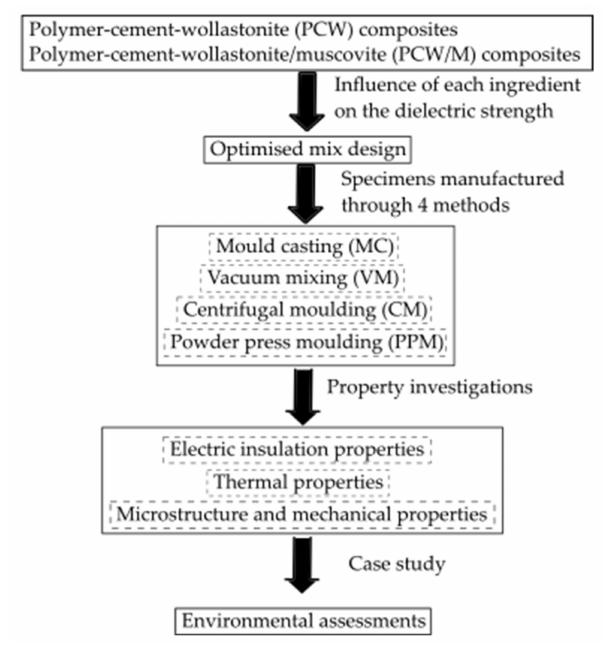
Figure 1. Flow chart of the experimental